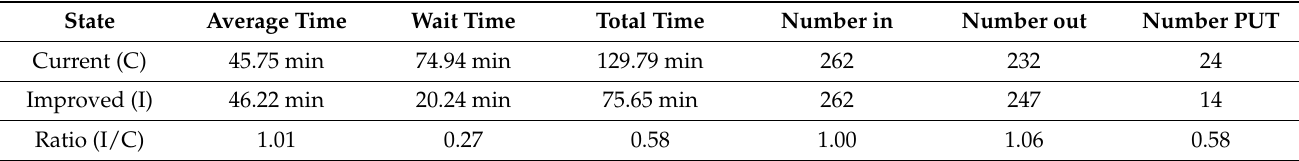
Table 12. Comparison between the current state and improved